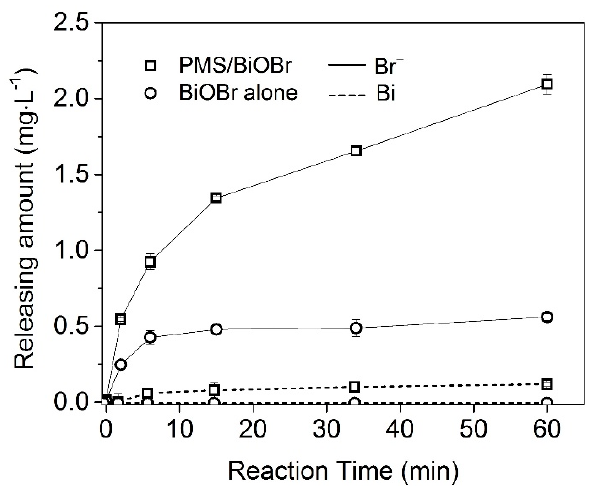
Figure 4. Leaching of Bi and Br − during the degradation process. BiOBr dose 0.5 g · L − 1 , [CBZ] 0 = 5 µ M, [PMS] 0 = 4.0 mM, pH = 7.0, T = 24 °C.